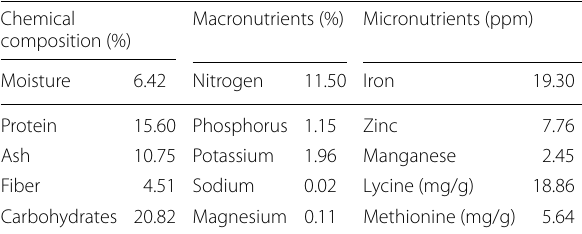
Table 5 Chemical composition and mineral concentration of algae Chemical composition